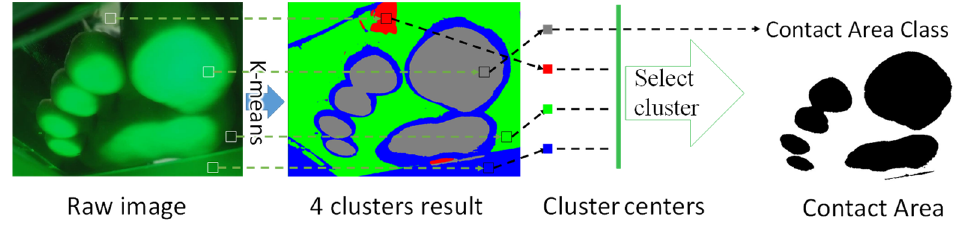
Figure 6. Overview of the contact area extraction process.